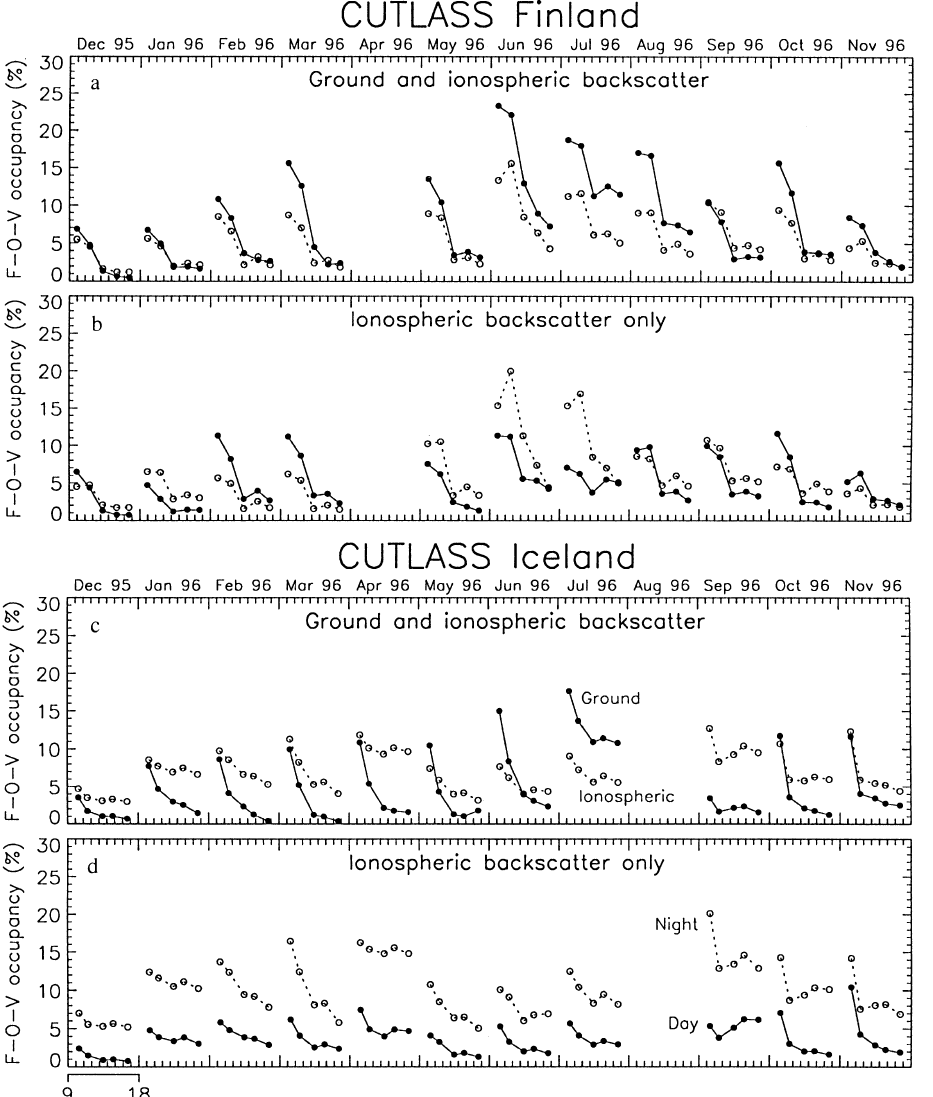
Fig. 11a-d. The variation in the occurrence of ground and iono- spheric backscatter observed by the CUTLASS radars as a function of